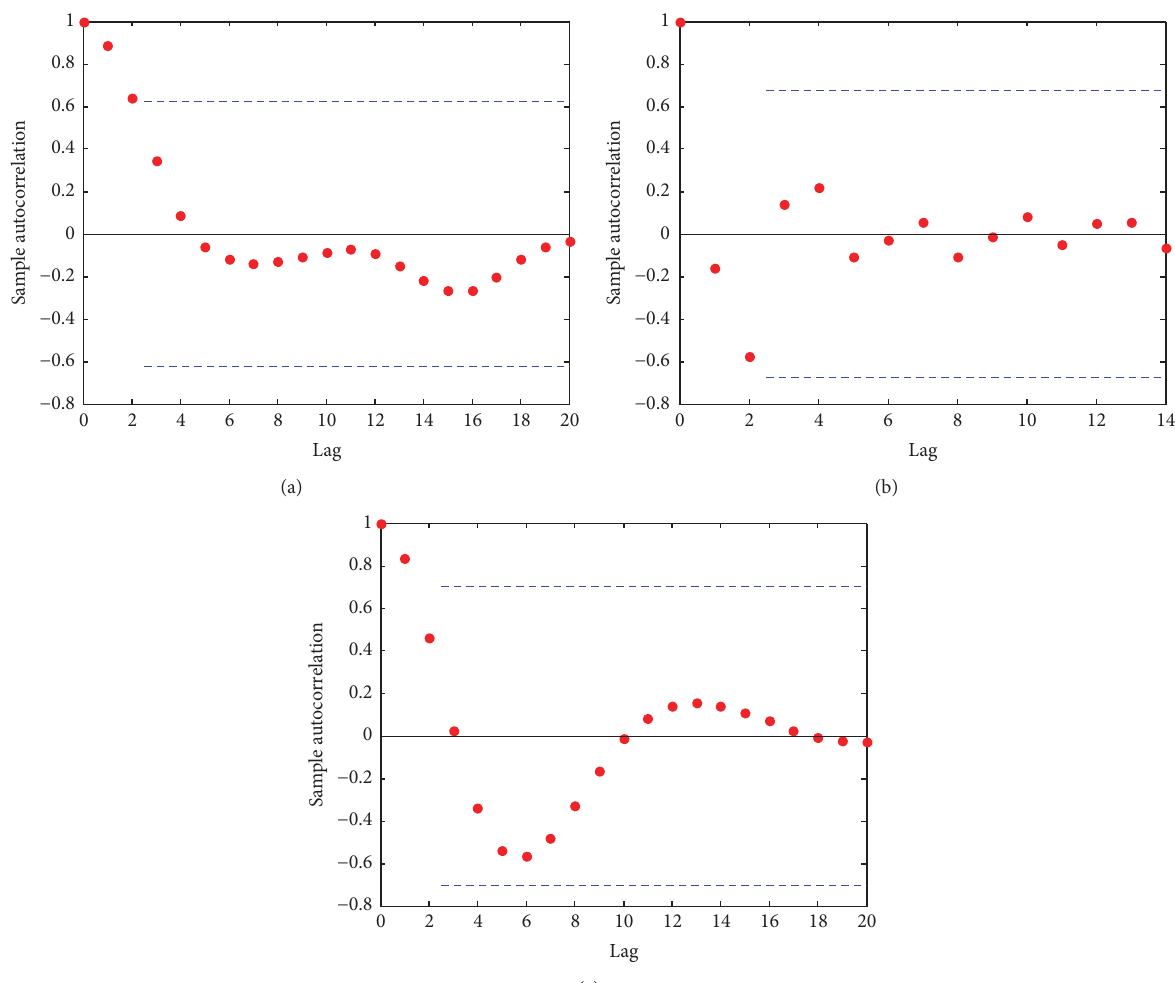
Figure 6: ACF of the models residuals (a) LSSVM, (b) WNN, and (c)